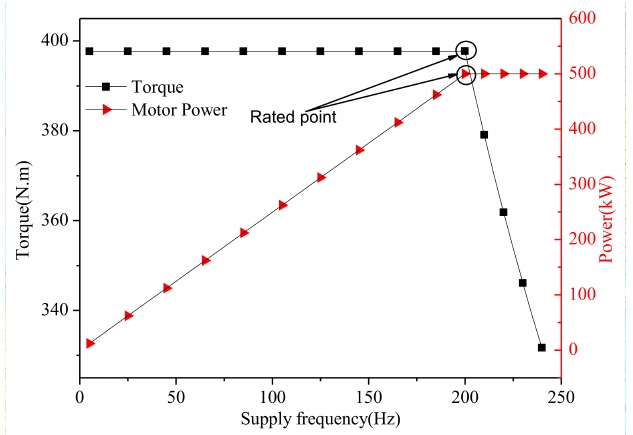
Figure 10. The operating characteristics of HTS induction motor.